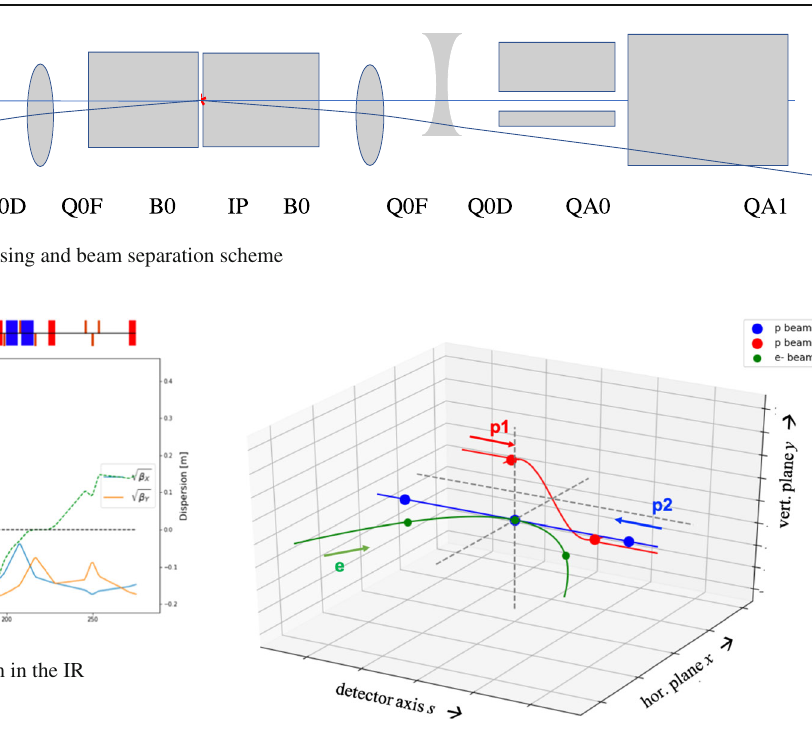
Fig. 17 Schematic view of the three beams in the interaction region. Collisions between electrons and proton beam 1 and a well separated proton beam 2